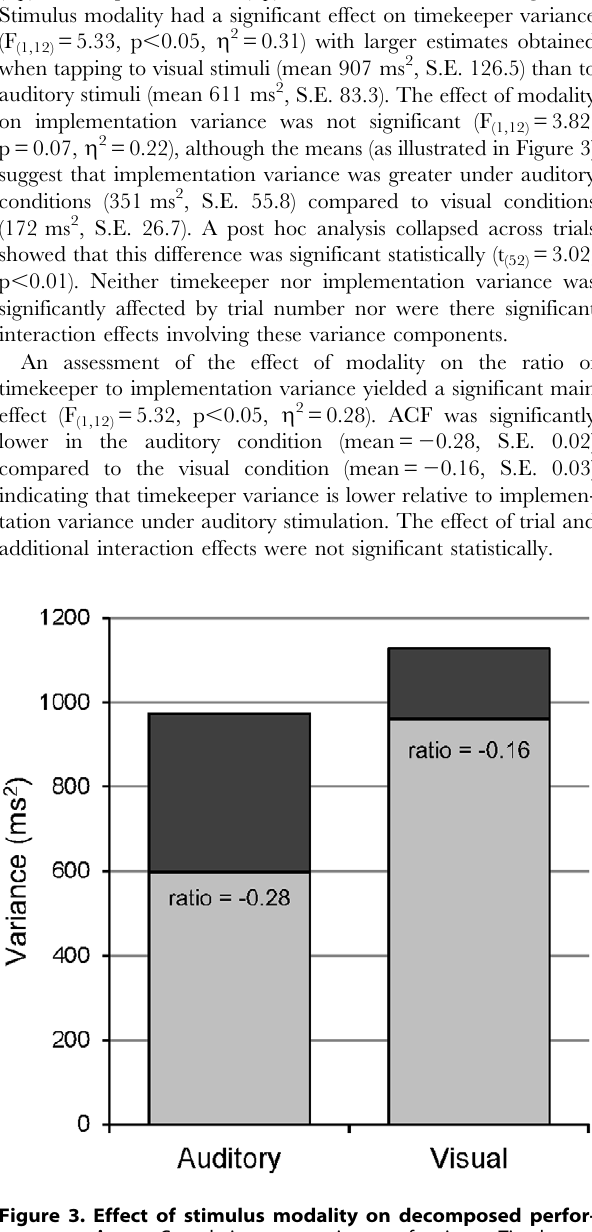
Figure 3. Effect of stimulus modality on decomposed perfor- mance variance. Cumulative mean estimates of variance. Timekeeper (light grey) and implementation variance (dark grey) are shown across the two stimulus conditions. Ratio values indicate the ACF which represents the relative amounts of variance from each source.